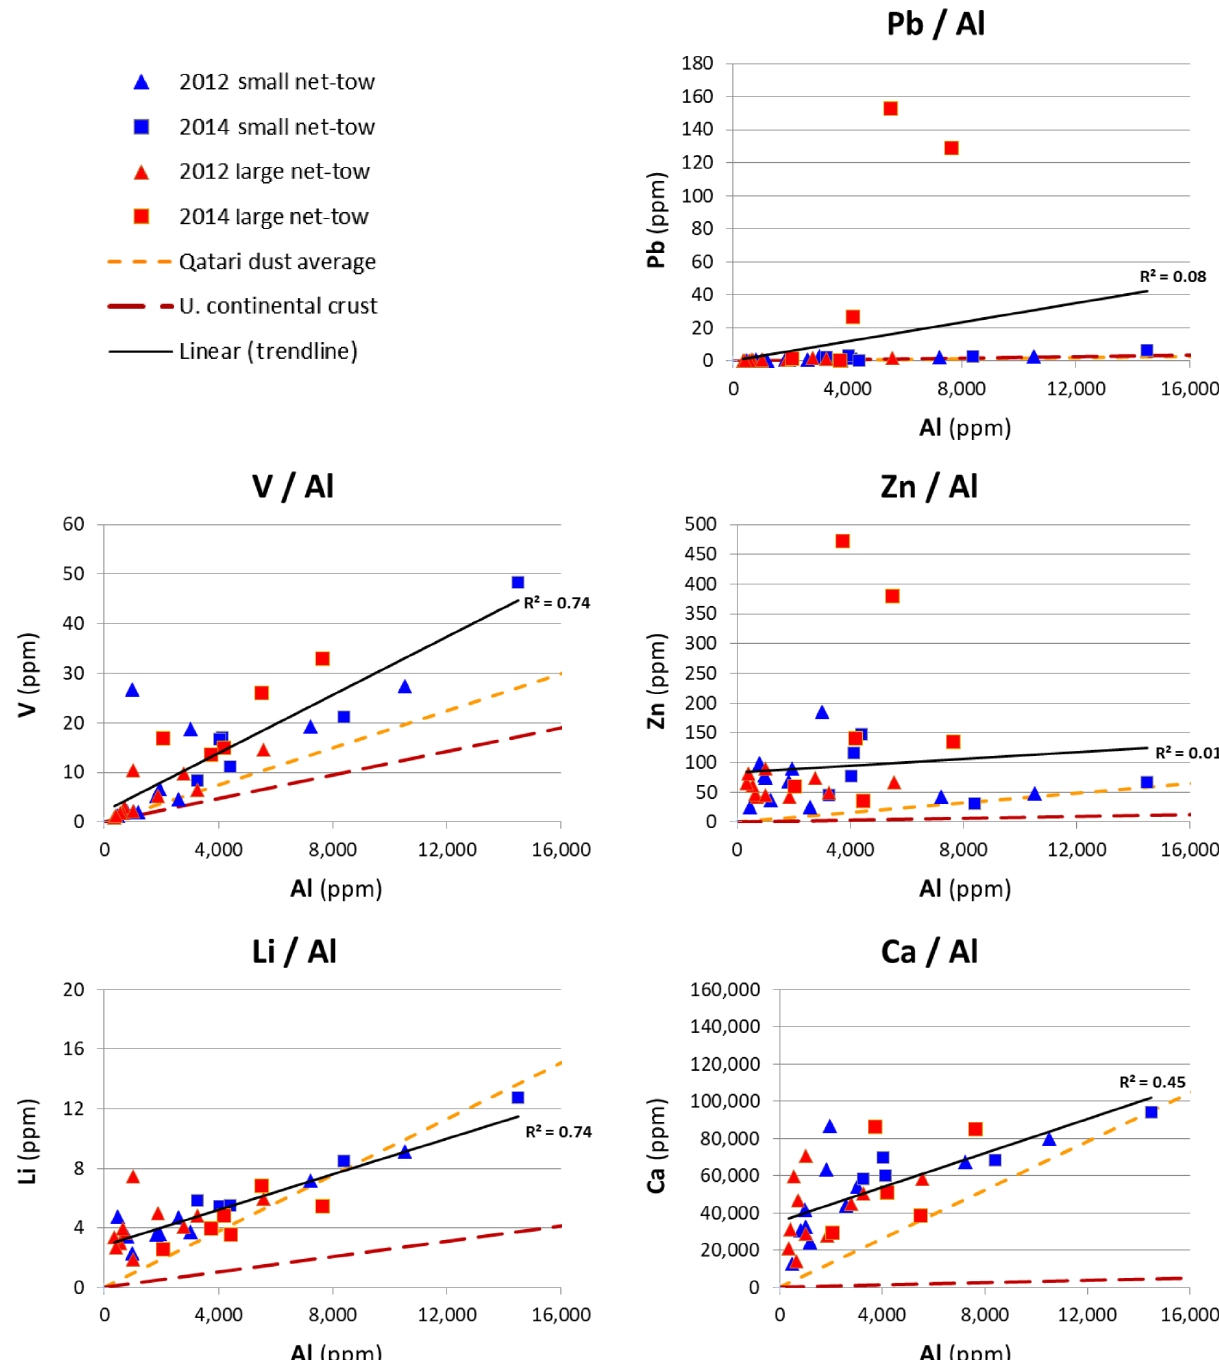
Figure 6. Metal / Al ratios for the 2012 and 2014 net-tow samples. The dashed lines represent the Me / Al in average Qatari dust (Yigiterhan et al., 2018) and Upper Continental Crust (Rudnick and Gao, 2003) values. The solid lines represent to best-fit lines for cumulative values of plankton samples. All concentrations are given in